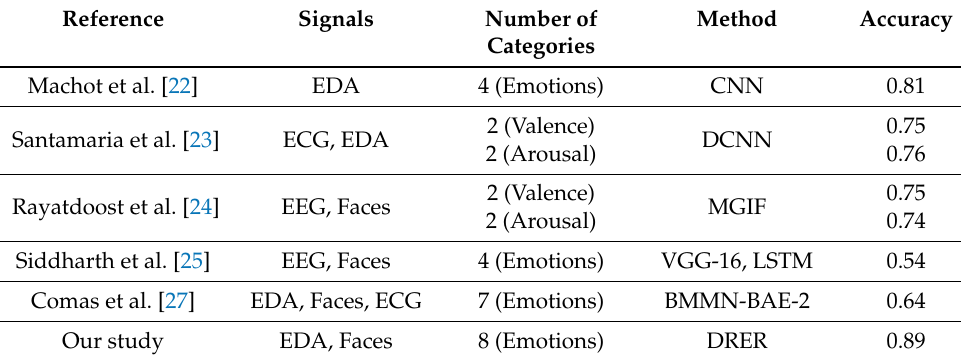
Table 8. State-of-the-art algorithms for emotion